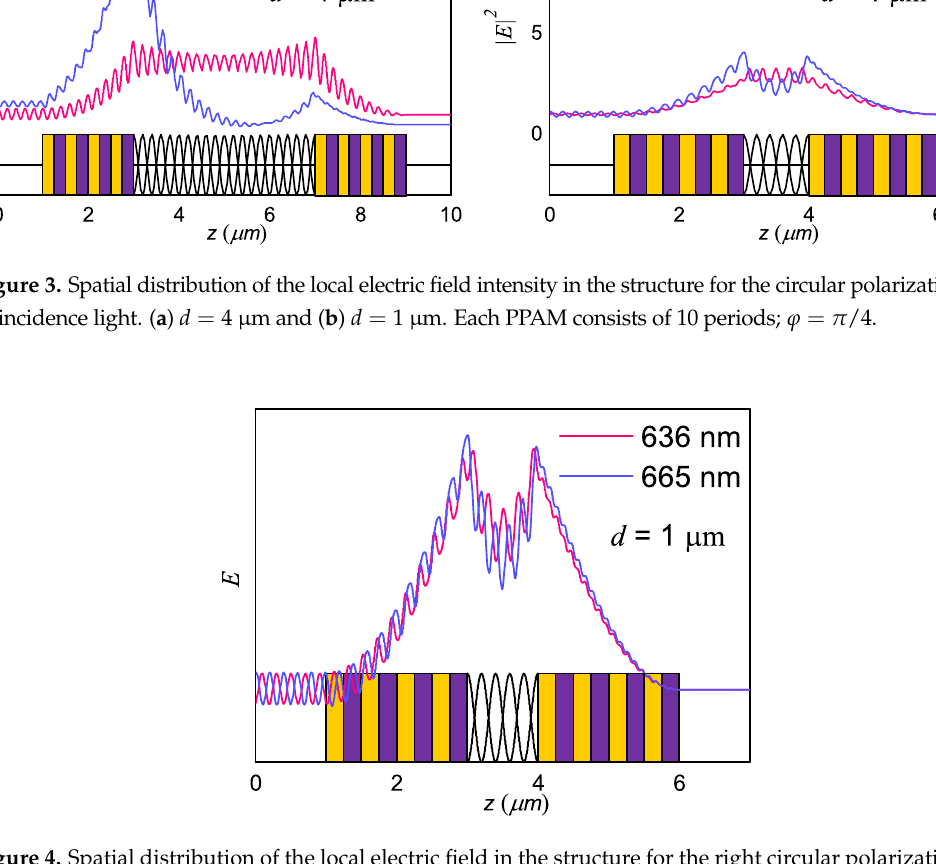
Figure 4. Spatial distribution of the local electric field in the structure for the right circular polarizations of incidence light. Each PPAM consists of 10 periods; d = 1 µ m, ϕ = π